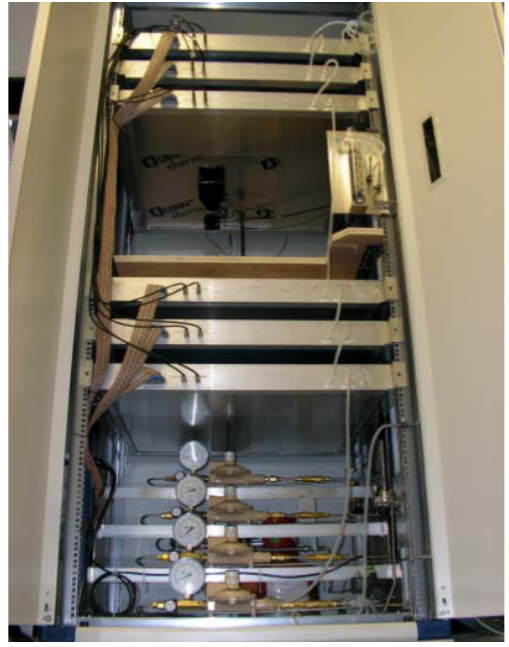
Fig. 2. Picture of the fully assembled system. The six aluminium cassettes contain two RPCs each and provide XY readout. The cas- settes also provide connections for high voltage, low voltage, data and gas lines. The gas mixing system is visible at the bottom of the